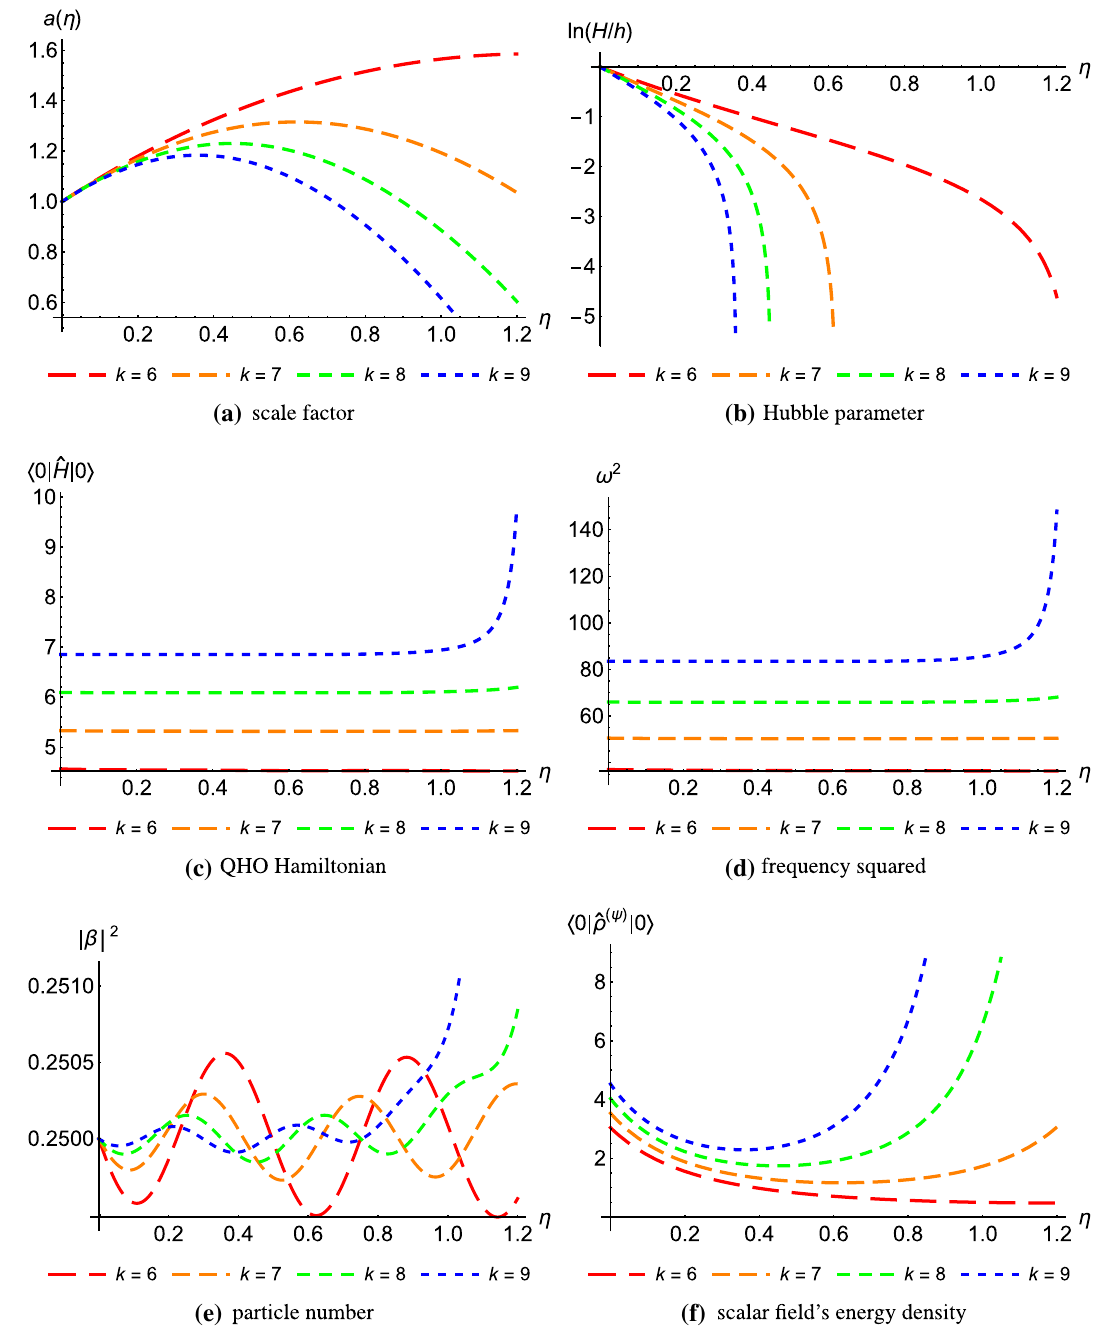
Fig. 4 Plots of a scale factor, a , b Hubble parameter, H = a (cid:8) / a 2 , c QHO Hamiltonian, (cid:4) 0 | ˆ H | 0 (cid:5) , d frequency squared, ω 2 , e particle number, | β | 2 , and f scalar field’s energy density, (cid:4) 0 | ˆ ρ (ψ) | 0 (cid:5) , obtained using the CQC for k = 6 , 7 , 8 , 9 with a 0 = 1 and h = 1